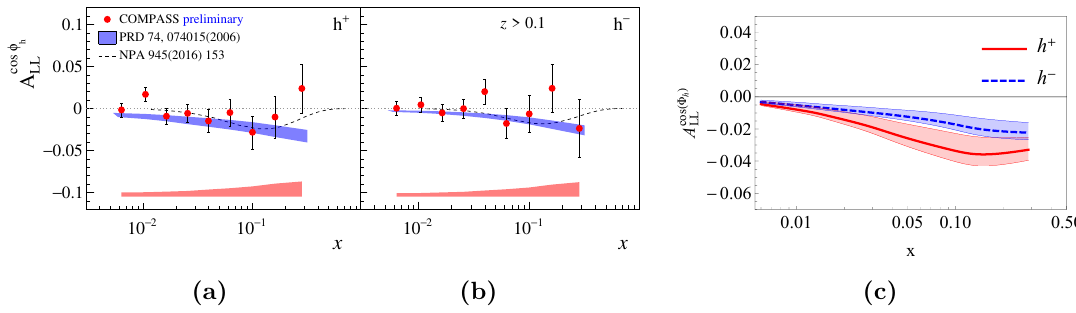
Figure 16. A cos( (cid:30) h ) as a function of x : preliminary COMPASS data [176, 180] (a,b), and our LL calculation for COMPASS kinematics in WW-type approximation (c) shown separately for reasons explained in the caption of (cid:12)gure